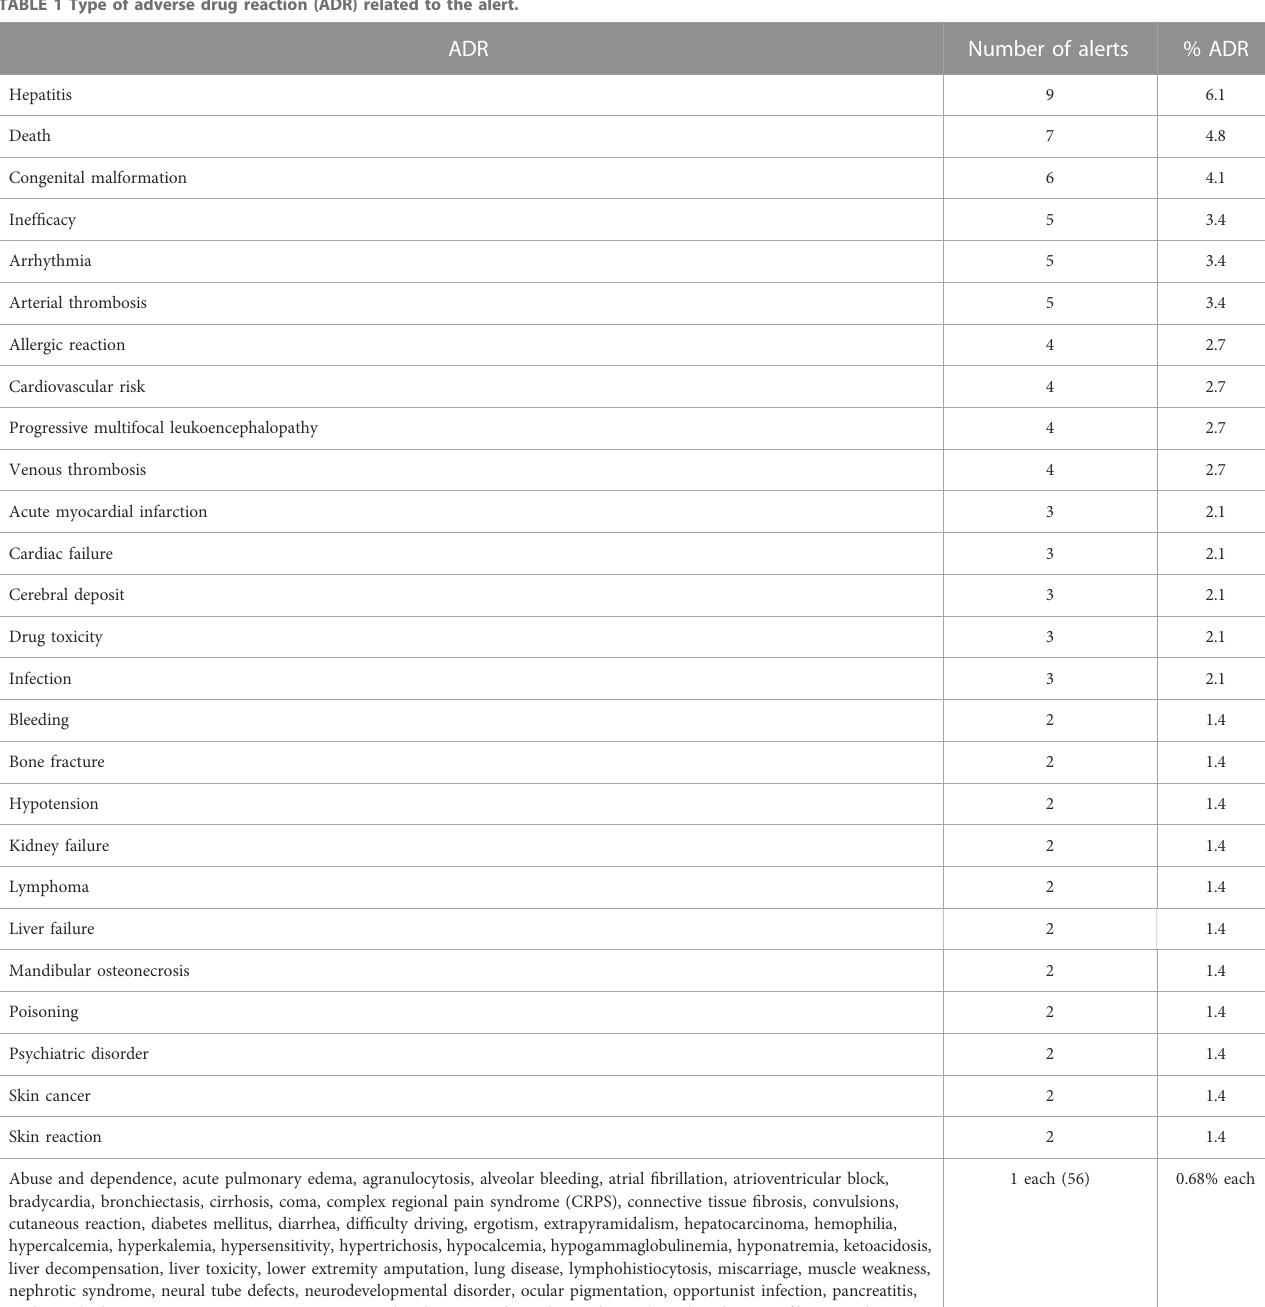
TABLE 1 Type of adverse drug reaction (ADR) related to the alert.